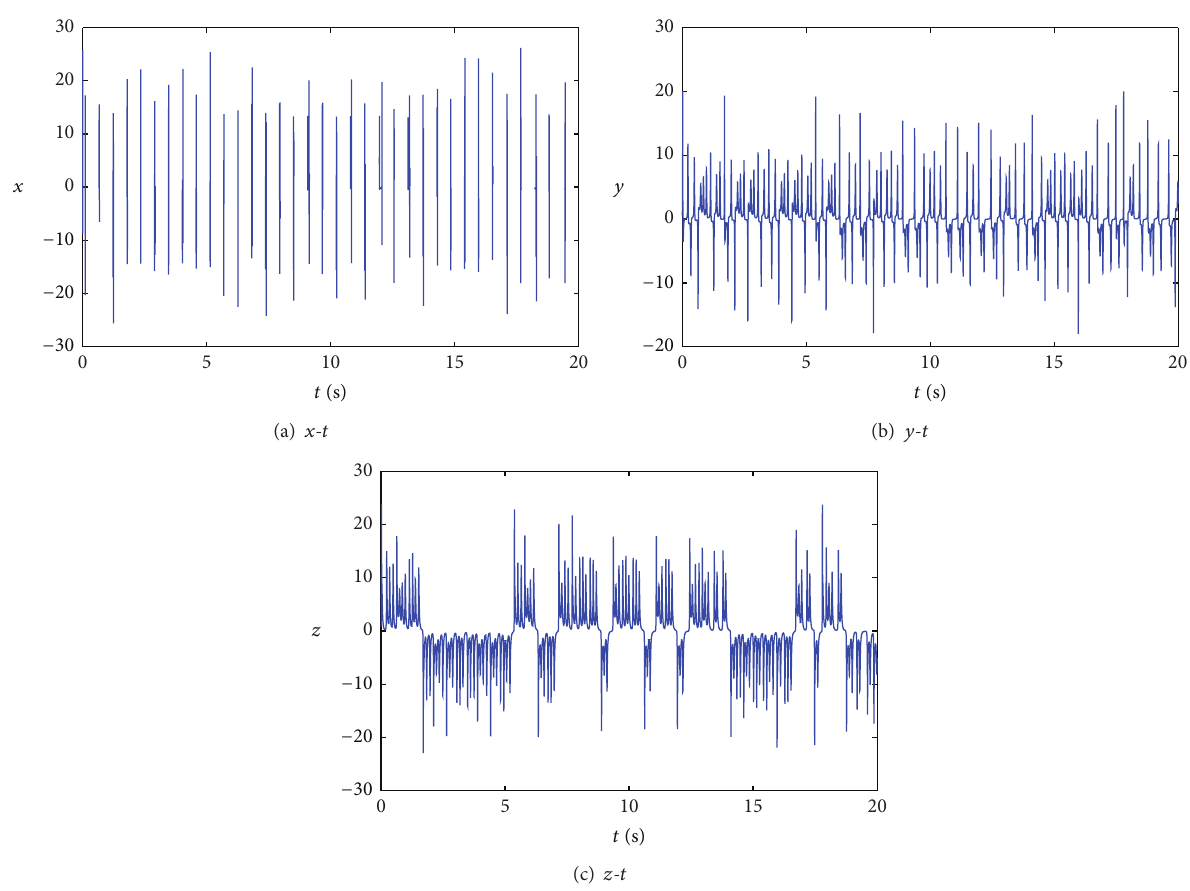
Figure 10: State trajectories of system (8) without